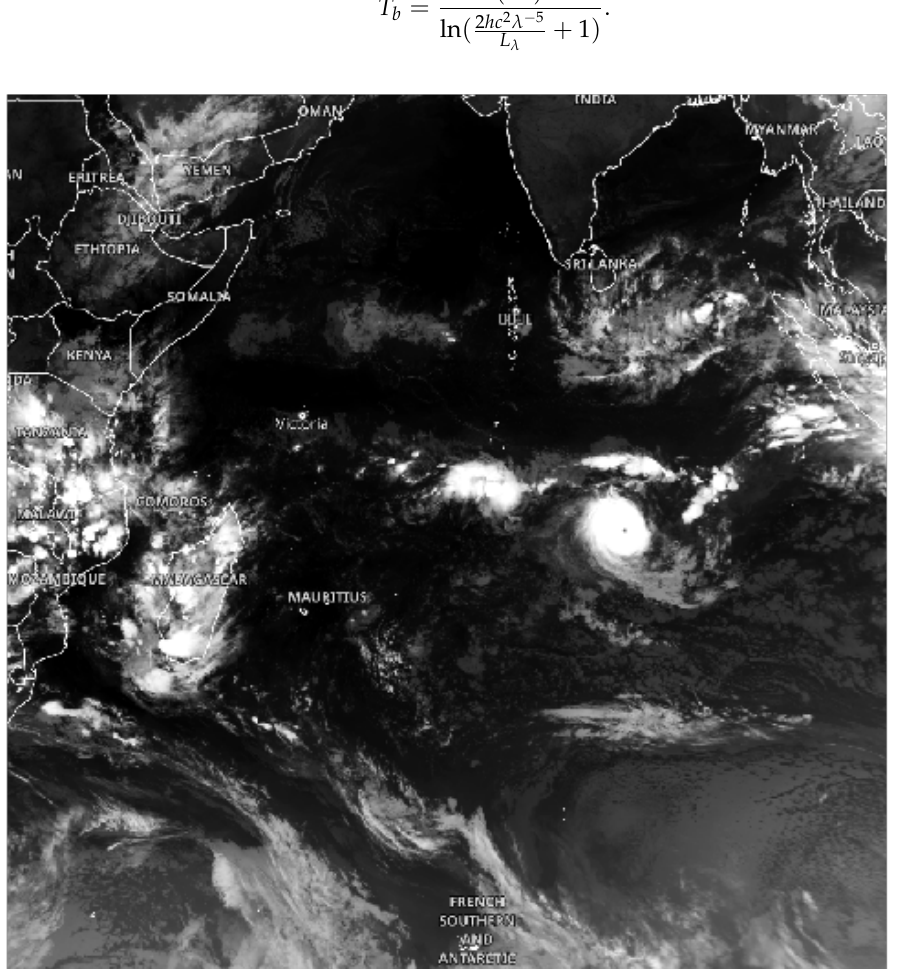
Figure 1. SEVIRI raw image of 8 February 2021, 18.00 UTC, showing the geographical impact area of the Faraji cyclone during its phase of maximum